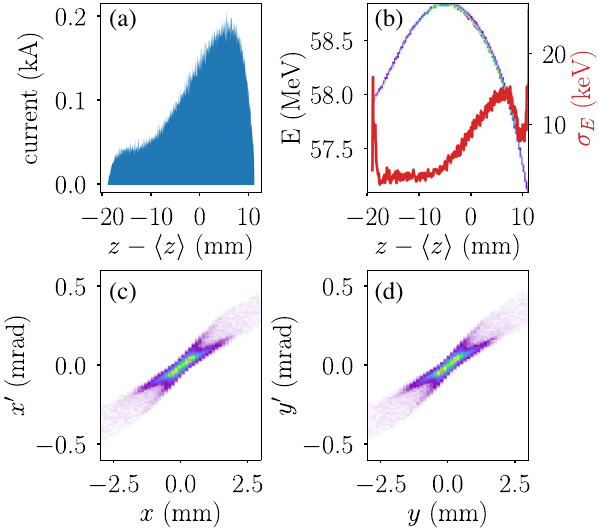
FIG. 6. Current profile (a) with associated LPS (b), and horizontal (c) and vertical (d) phase-space distributions simulated with ASTRA at the end of the photoinjector (11.67 m from the photocathode). In plot (b), the red trace represents the slice rms energy spread σ E